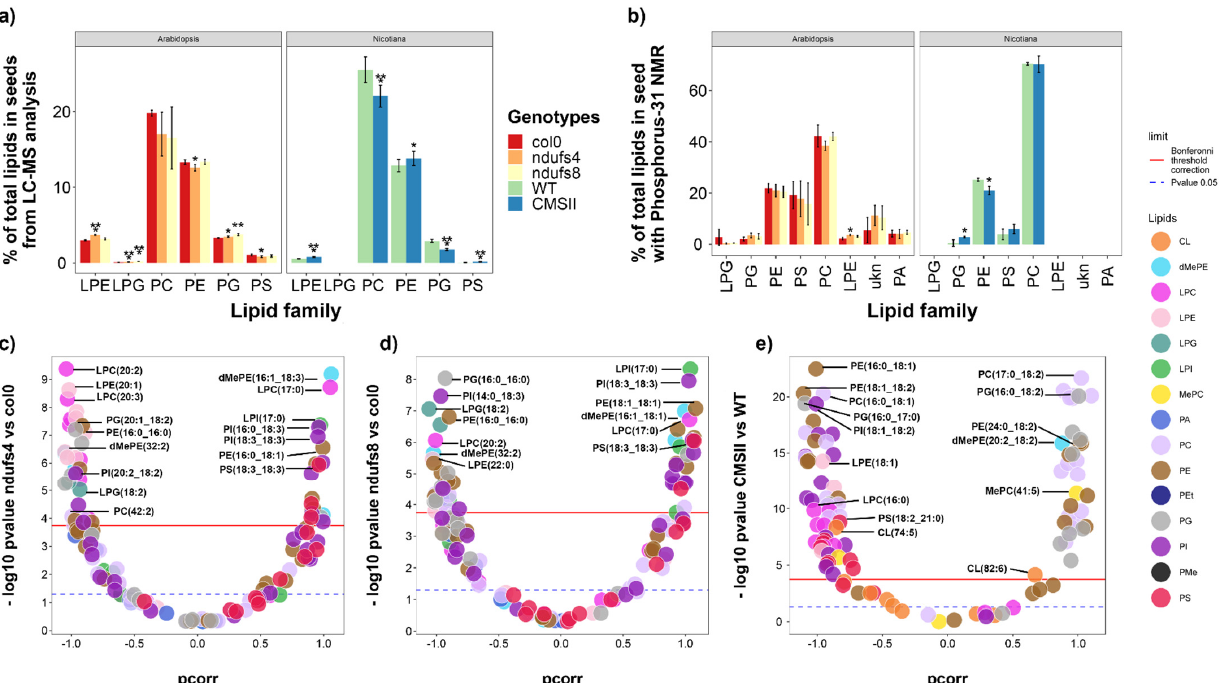
Figure 6. Seed phospholipid pattern from both LC ‐ MS and 31 P NMR analysis in wild ‐ type and CI mutants: CMSII (tobacco) and ndufs4 and ndufs8 (Arabidopsis). ( a ) Phospholipid families’ contents in percentage of total LC ‐ MS signal. ( b ) Phospholipid families in percentage of total absolute phospholipid amount determined by 31 P ‐ NMR. ( c – e ) Volcano plots showing the weight in sample discrimination (p corr value from OPLS ‐ DA multivariate analysis) against the p ‐ value (Welch t ‐ test, univariate analysis) to show best lipid biomarkers between mutants (on the left) and wild ‐ type (on the right). The colour legend on right indicates phospholipid subfamilies in ( c ‐ e ). A magnified version of this figure is provided in Supplementary Materials. Asterisks refer to statistical significance (*, p